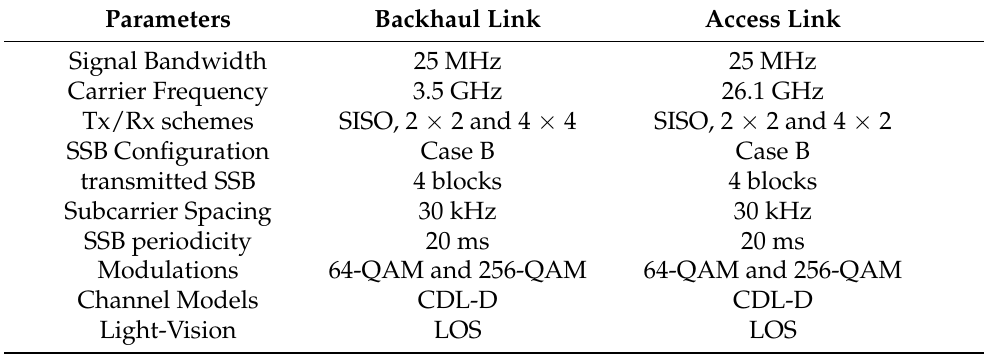
Table 2. Main parameters of simulation.